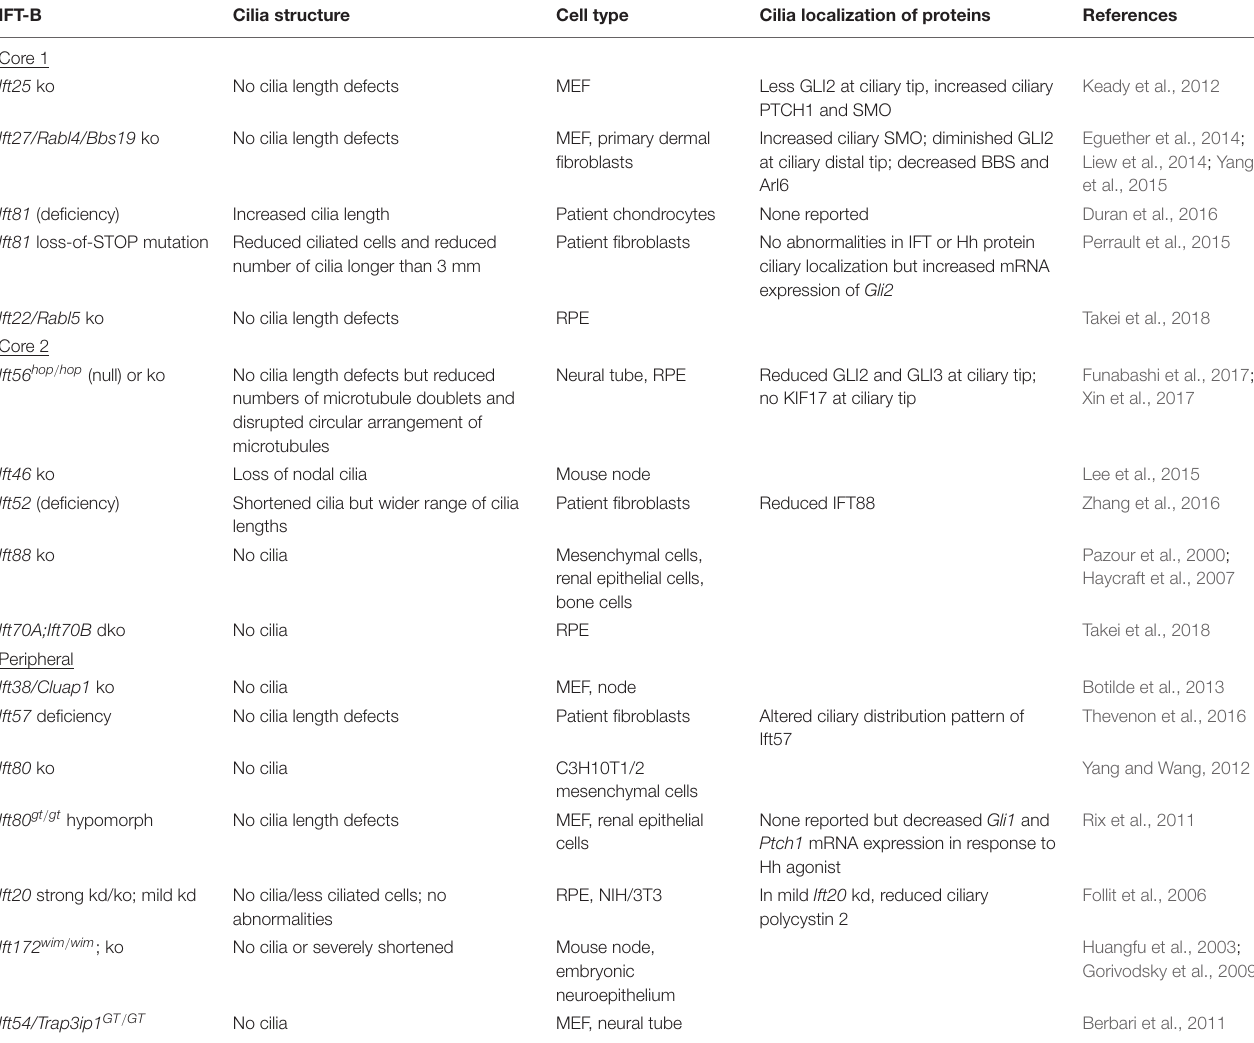
TABLE 2 | Mammalian IFT-B ciliary